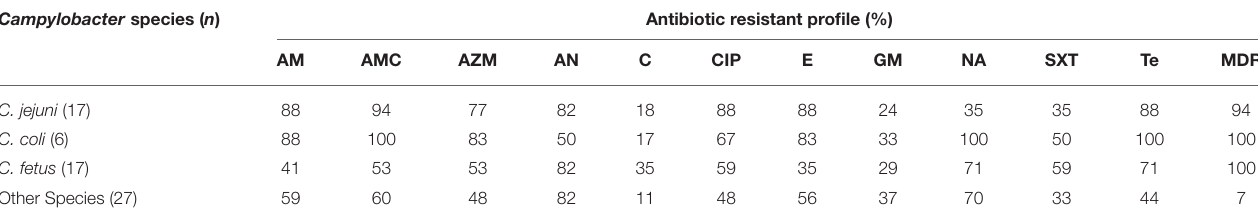
TABLE 6 | Resistance of antimicrobials across Campylobacter